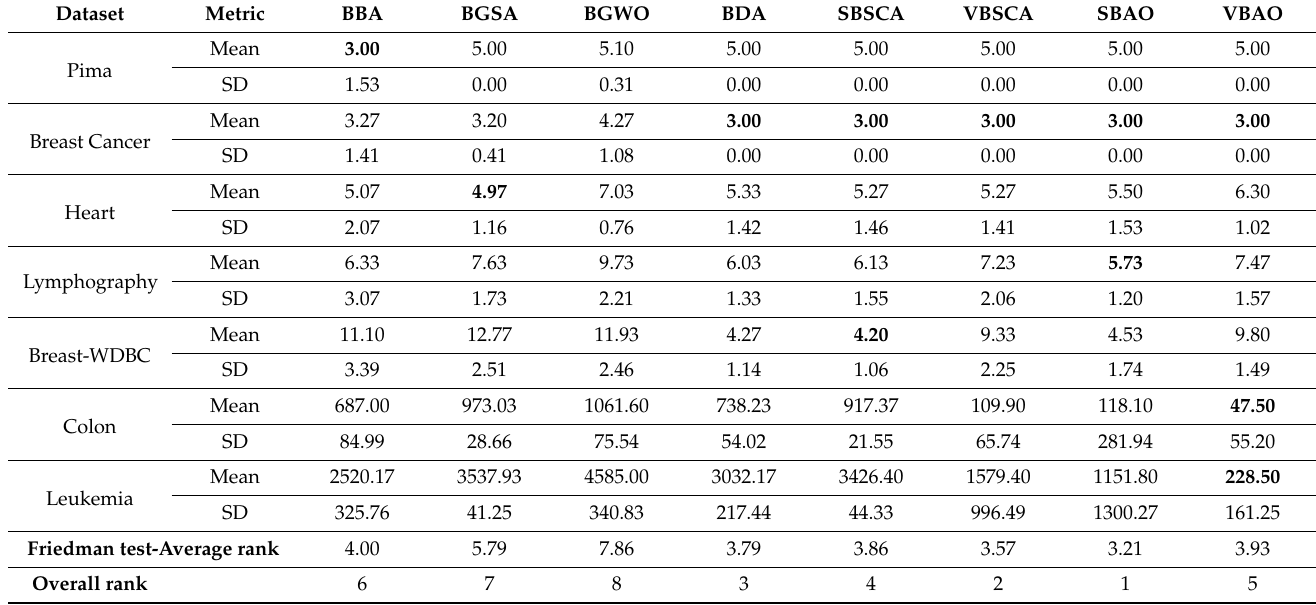
Table 8. The number of selected features comparison of SBAO and VBAO with comparative